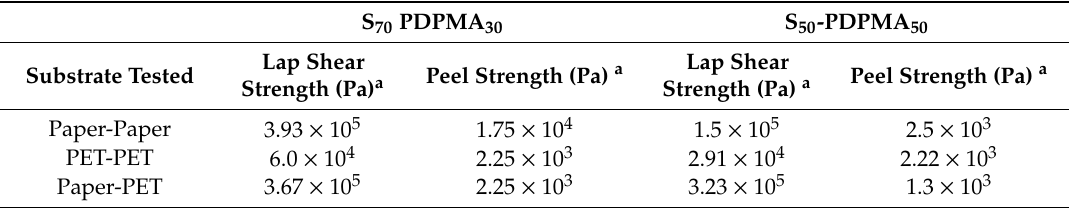
Table 5. Adhesion properties of styrene-PDPMA copolymers on di ff erent